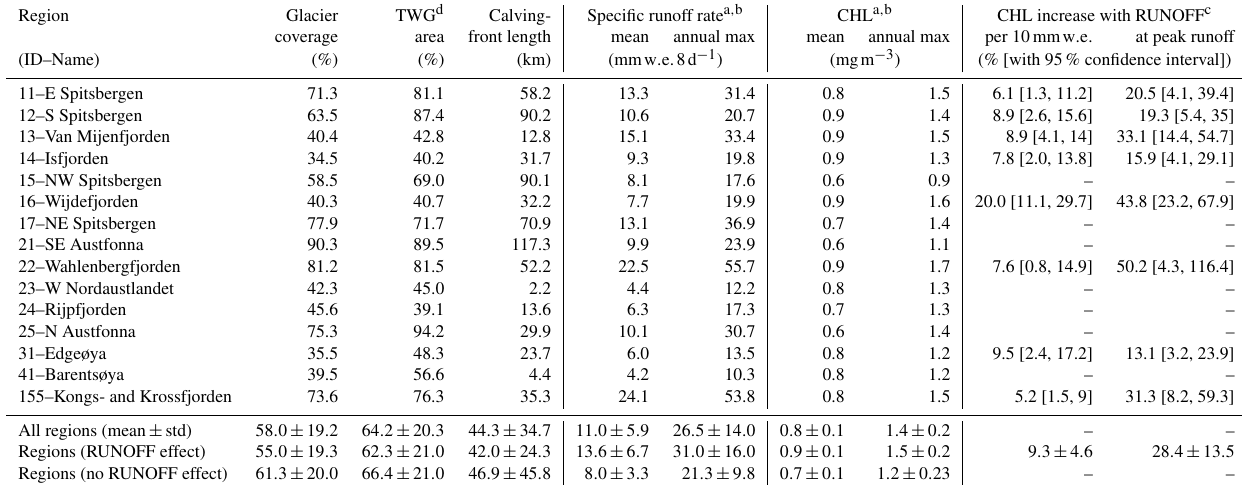
Table 1. Glacier configuration and runoff characteristics for primary hydrological regions of Svalbard, including subregion Kongsfjorden– Krossfjorden. Region Glacier TWG d